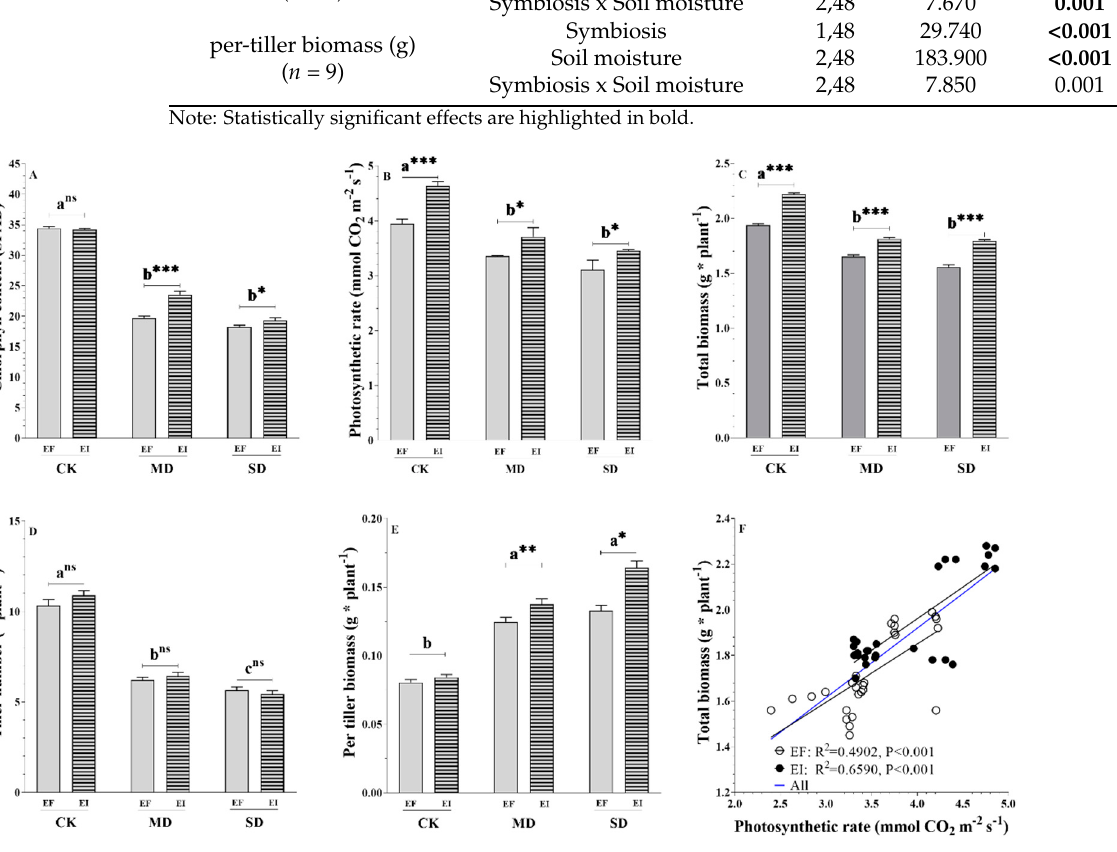
Figure 3. The chlorophyll content ( A ), photosynthetic rate ( B ), total biomass ( C ), the tiller number ( D ), and per tiller biomass ( E ) of Epichloë symbiotic (EI) and non-symbiotic (EF) plants under normal (CK), moderate drought (MD), and severe drought (SD) treatments, and liner linear regression ( F ) between photosynthetic rate and total biomass. Note: Different lowercase letters mean significant difference at p < 0.05 among three soil moisture treatments at the 0.05 level. The *, ** and *** mean significant differences between EI and EF plants at the corresponding water content at the 0.05, 0.01 and 0.001 levels, respectively. Table 2. ANOVA table showing the effects of plant symbiosis status and soil moisture levels on the tiller number, biomass, chlorophyll content, and photosynthetic rate of Achnatherum inebrians plants symbiotic with the fungal endophyte Epichloë gansuensis .